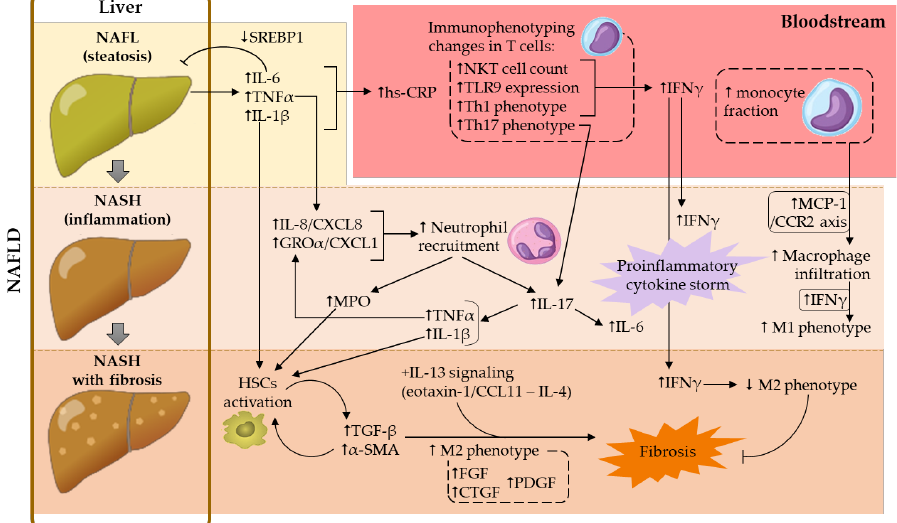
Figure 1. Contribution of the main cellular and soluble mediators studied in NAFLD development. α -SMA, α -smooth muscle actin; CTGF, connective tissue growth factor; FGF, fibroblast growth factor; GRO α , growth regulated protein- α ; hs-CRP, high-sensitivity C-reactive protein; HSCs, hepatic stellate cells; IFN γ , interferon- γ ; IL, interleukin; MCP-1, monocyte chemoattractant protein-1; MPO, myeloperoxidase; NAFL, non-alcoholic fatty liver; NAFLD, non-alcoholic fatty liver disease; NASH, non-alcoholic steatohepatitis; NKT, natural killer T; PDGF, platelet-derived growth factor; SREBP1, sterol regulatory element binding protein-1; TGF- β , transforming growth factor- β ; Th, T helper; TLR9, toll-like receptor 9; TNF α , tumor necrosis factor- α